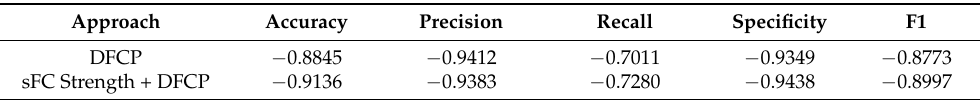
Table 4. Correlation coefficients between time window length and classification performance metrics for COBRE